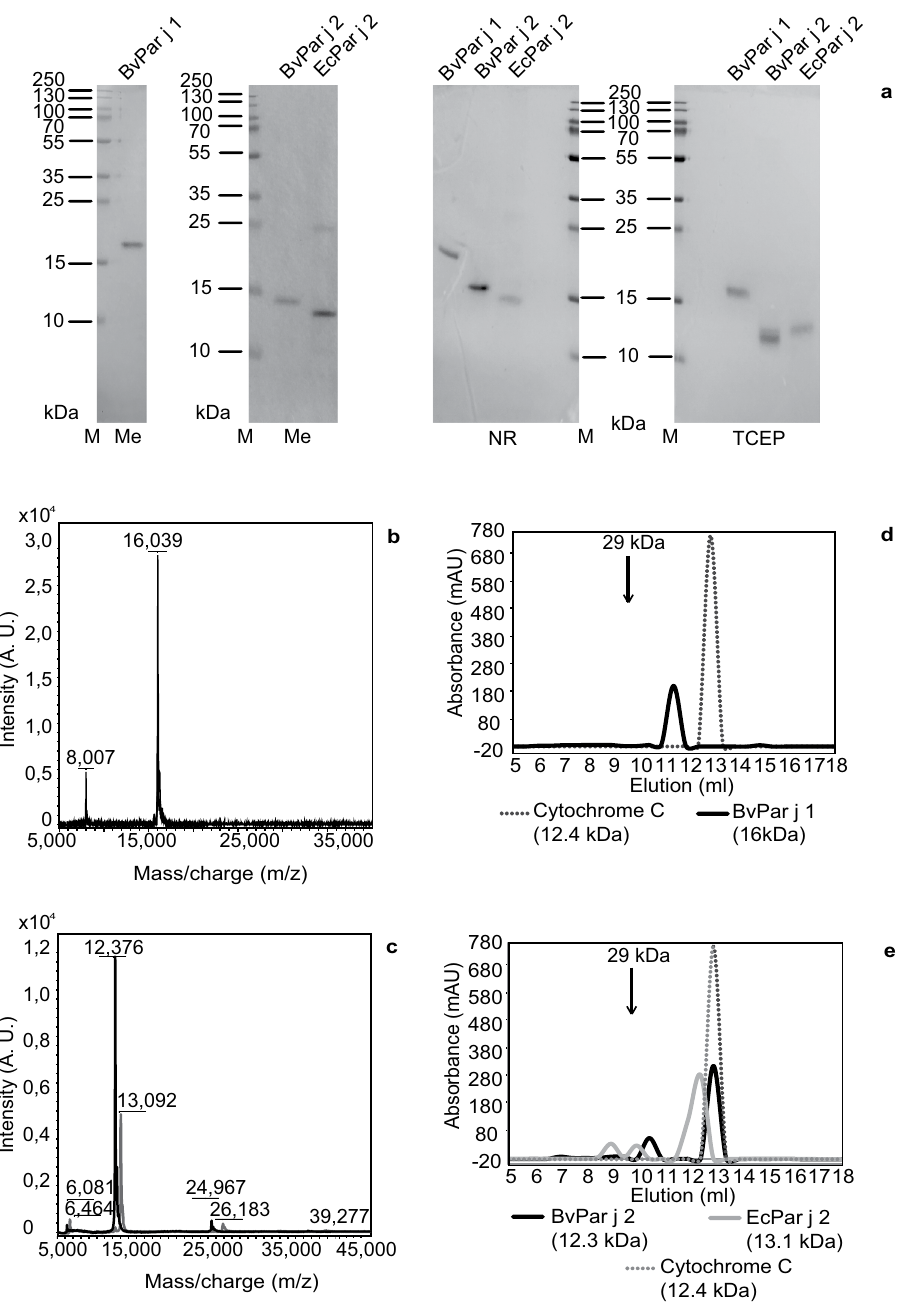
Figure 2. Biochemical and biophysical characterization of purified BvPar j 1, BvPar j 2 and EcPar j 2. Coomassie brilliant blue-stained SDS-PAGE containing purified BvPar j 1, BvPar j 2 and EcPar j 2 ( a ) separated under non-reducing conditions (panel NR), reducing conditions using β -Mercaptoethanol (panel Me) or Tris(2-carboxyethyl)phosphine (panel TCEP). Molecular weight markers are indicated on the left margins in kilo Dalton (kDa). Full-length gels are presented in Supplementary Fig. S1. Matrix-assisted laser desorption and ionization-time-of-flight (MALDI-Tof) analysis of ( b ) BvPar j 1, ( c ) BvPar j 2 (black) and EcPar j 2 (grey). The mass/charge ratios are indicated on the x-axes, and the intensities are shown as absorption units of the most intensive signals obtained in the mass range (y-axes). Analysis of ( d ) BvPar j 1, ( e ) BvPar j 2 (black) and EcPar j 2 (grey) by gel filtration. Cytochrome C (dotted peak) and carbonic anhydrase (indicated by an arrow at 29 kDa) served as molecular weight standards. Elution volumes are shown in milliliters - mL (x-axes) and the absorbances of the proteins at 280 nm are indicated in milli-absorbance units - mAU